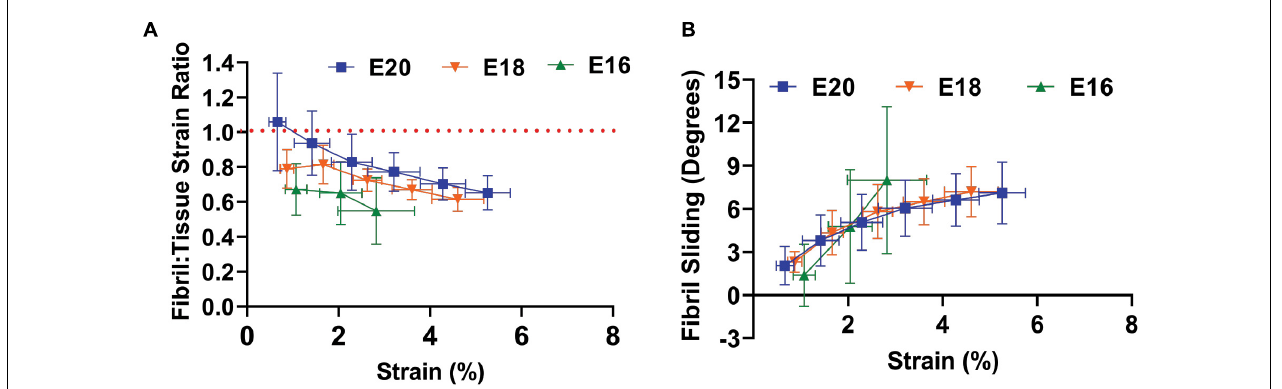
FIGURE 3 | Multiscale mechanical response of the flexor digitorum brevis (FDB) digit II tendon as a function of applied tissue strain with increasing development. (A) A significant increase in the fibril: tissue strain ratio was observed between E16 (HH42) vs. E18 (HH43; p < 0.05) and E16 (HH42) vs. E20 (HH46; p < 0.001). (B) No significant difference in the fibril sliding behavior was observed with developmental age. Significance was tested with a linear mixed model accounting for correlated strain increments per specimen as a covariate. Data represented as mean ± standard deviation.